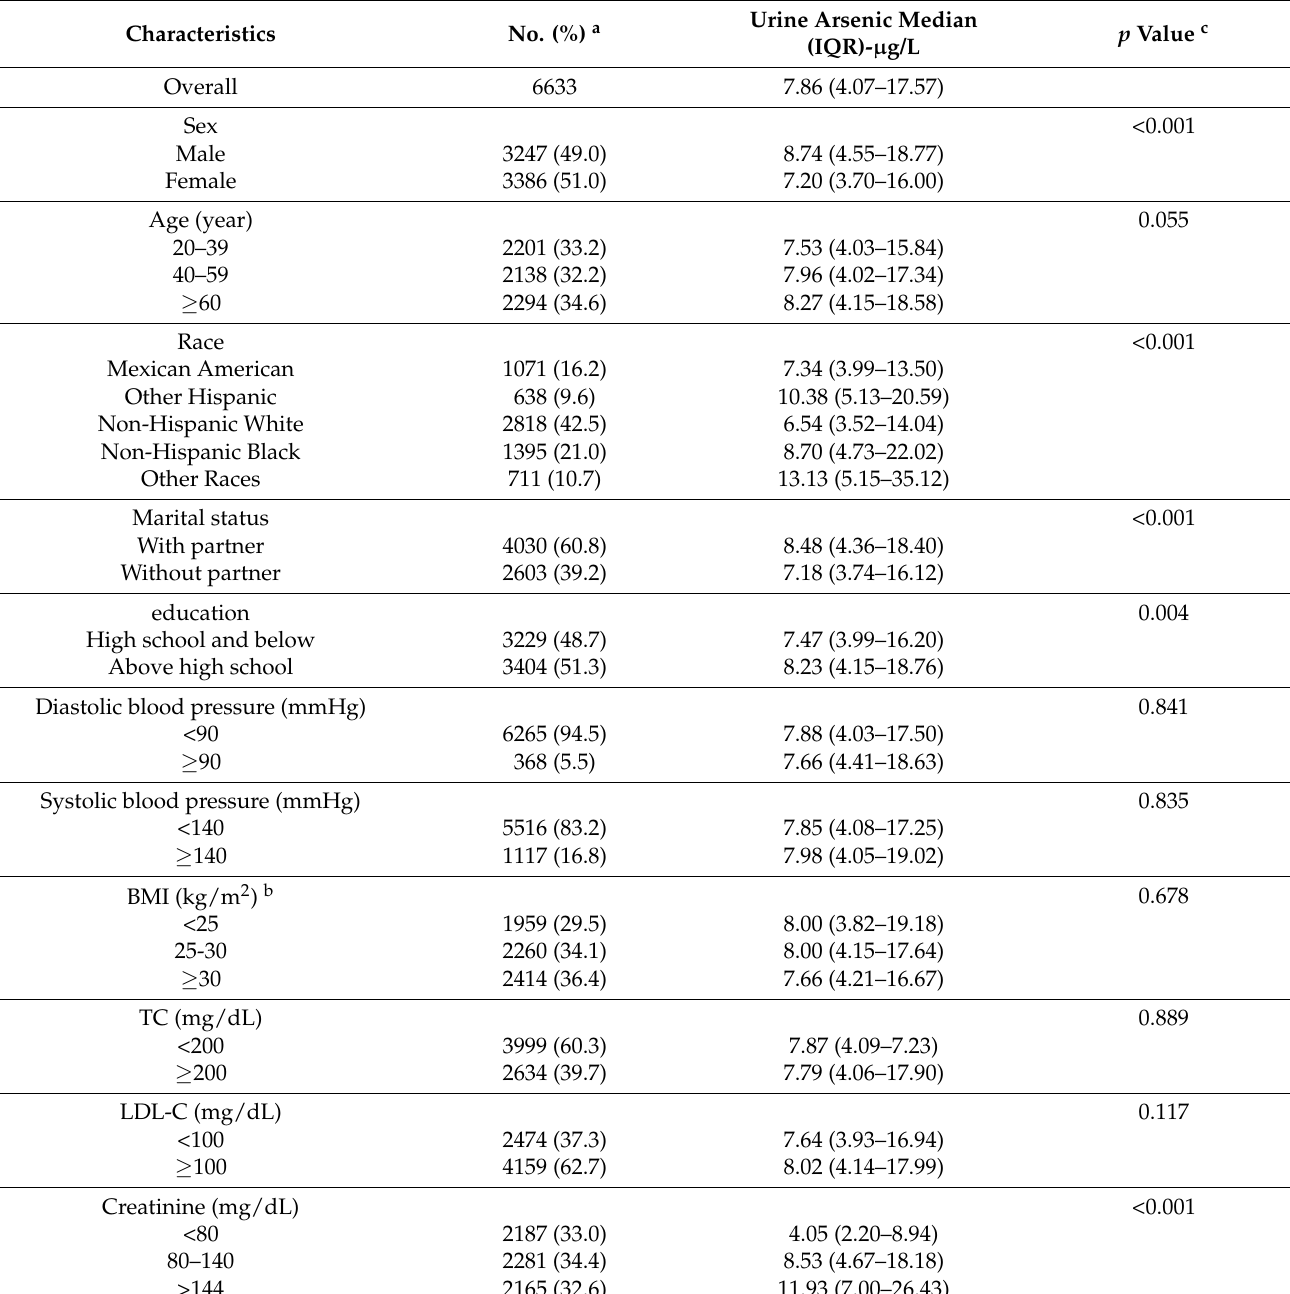
Table 1. Urine arsenic concentrations by participant